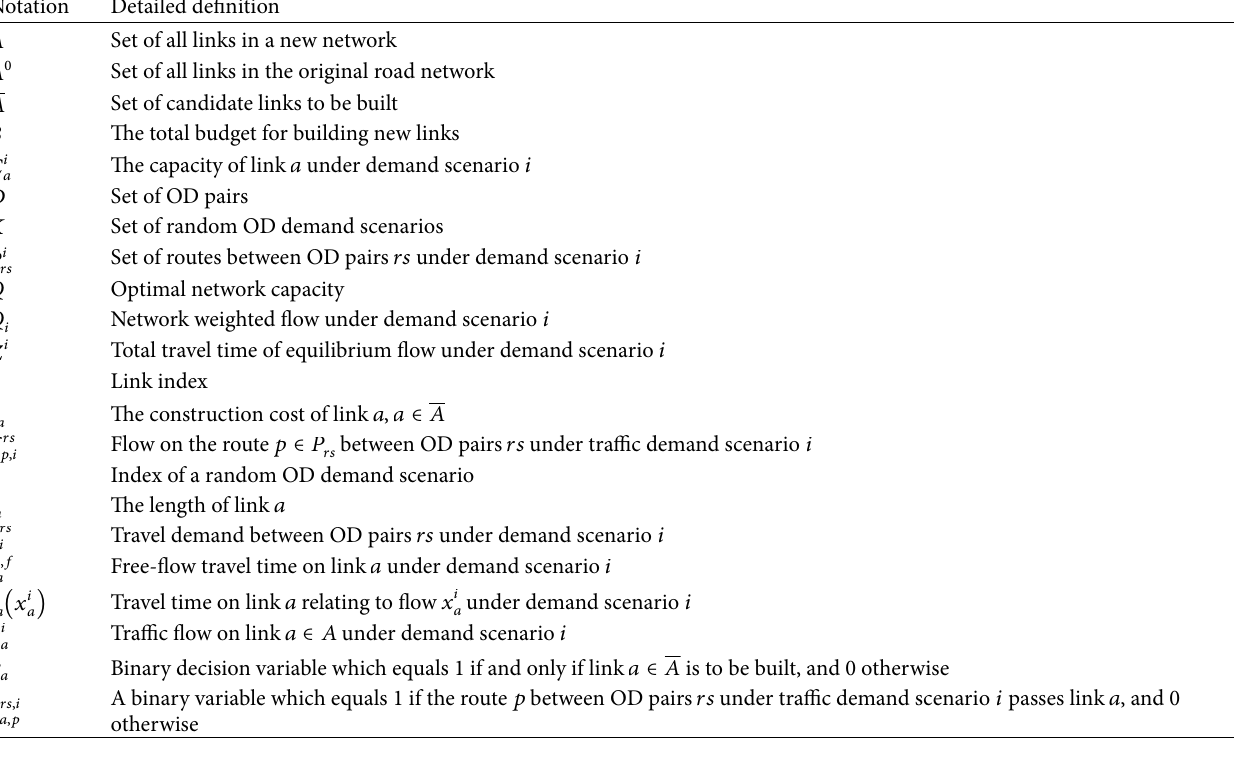
Table 1: Notations and definitions in model